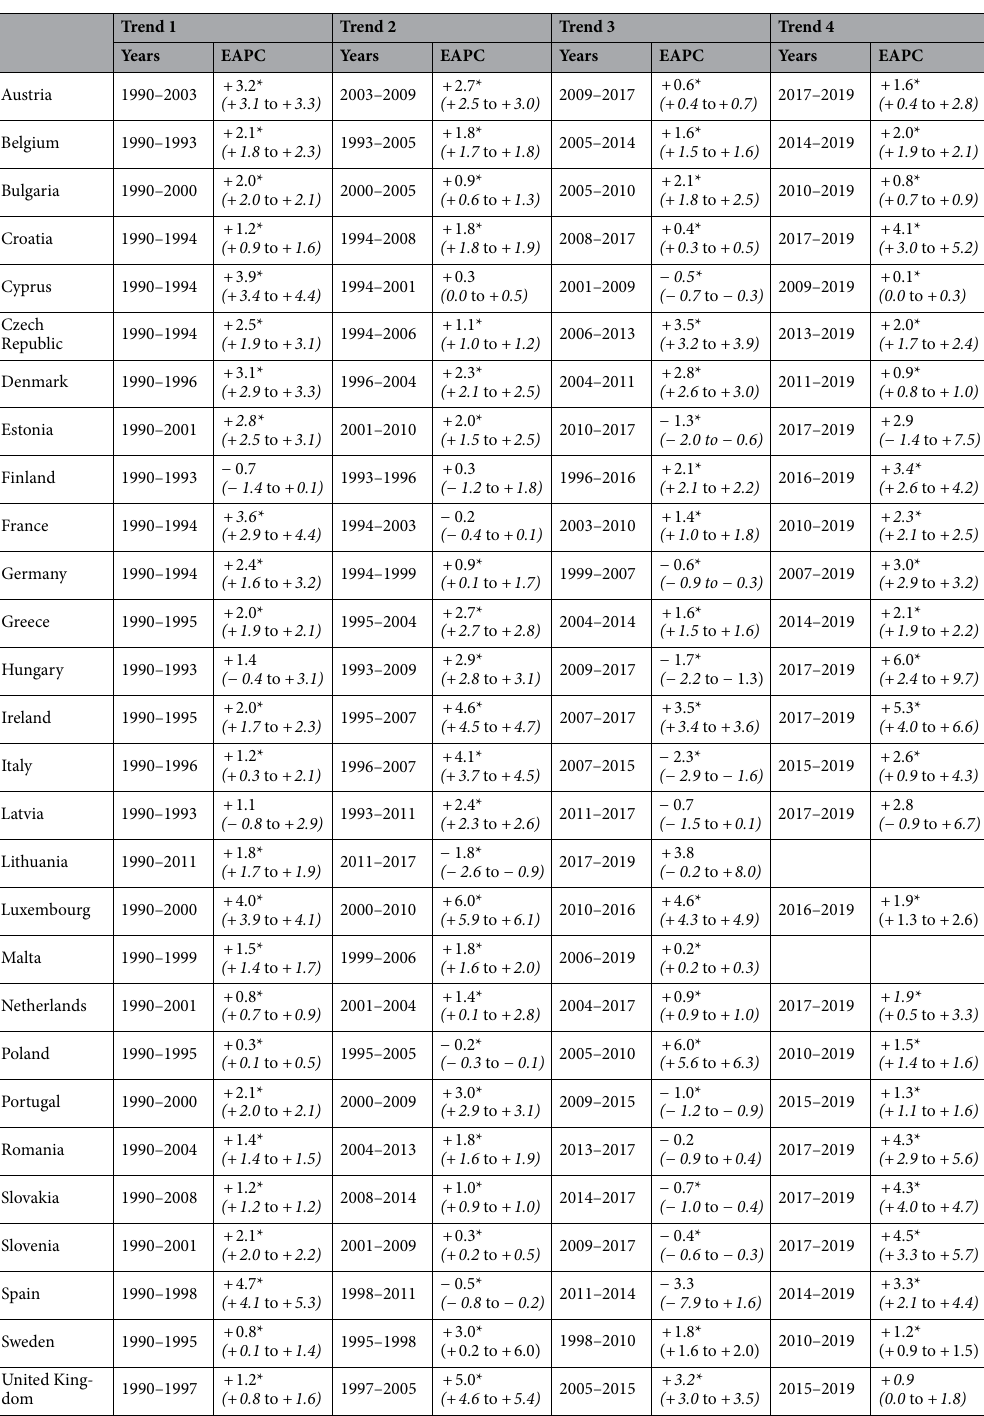
Table 3. Joinpoint analysis for age-standardised prevalence rates (ASPRs) per 100,000 population for type 2 diabetes (T2DM) in males. Italic values indicates 95% confidence intervals. Data presented as estimated annual percentage change (EAPC %), with 95% confidence intervals in brackets. P values deemed significant if <